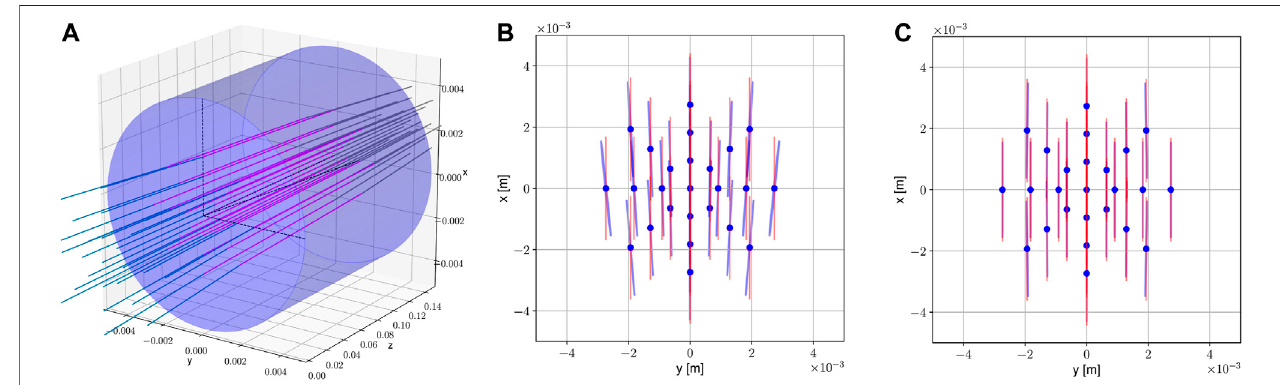
FIGURE 8 | Result of polarization ray-tracing with a Gaussian beam as input ( λ = 1064 nm, waist: 50 μ m at z = 0.5 m). Shown are 25 rays as representative of the passing Gaussian wavefront through a substrate with 0.5 ° c-axis misalignment in y - z -plane (A) : 3D illustration of the process; (B) : situation of the exited fi eld in 1 m distance; (C) : same as center but without c-axis misalignment)).